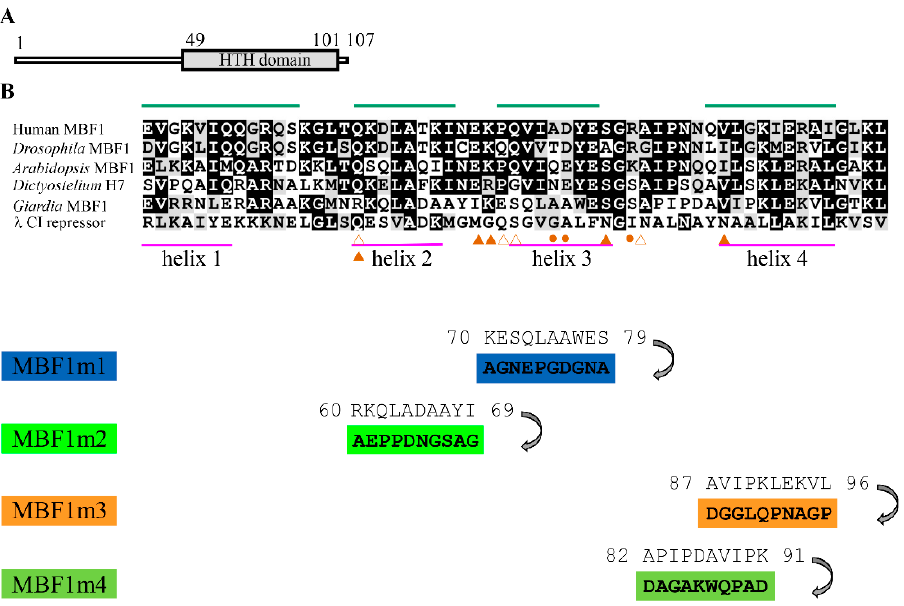
Figure 1. Domain architecture of multiprotein bridging factor 1 (MBF1) protein and alignment of the HTH domains. ( A ) Schematic representation of the Giardia MBF1 protein. The gray box indicates the helix-turn-helix (HTH) domain, as predicted by pfam. ( B ) Alignment of various HTH domains and sequence of Giardia MBF1 mutants. The MBF1 proteins from different organisms, including human, Drosophila , Arabidopsis , Dictyostelium and Giardia , are analyzed by ClustalW 1.83 with all default settings. GenBank accession numbers for human MBF1, Drosophila MBF1, Arabidopsis MBF1, Dictyostelium H7, Giardia MBF1, and λ CI repressor are NP_003783.1, NP_524110.1, NP_565981.1, CAA33444.1, XP_001704109.1, and AAK07889.1, respectively. Black and gray boxes indicate identical and conserved amino acids in the respective proteins, respectively. The predicted 4 α helixes of HTH domain of Giardia MBF1 and λ CI repressor are indicated by green and purple lines, respectively. The helix 2 and helix 3 are the core structure of λ CI repressor and the latter is the recognition helix. Amino acids of λ CI repressor that contact DNA major groove and DNA phosphates are indicated by filled and open triangles, respectively. The hydrophobic amino acids of λ CI repressor that increase DNA binding specificity are indicated by filled circles. MBF1m1 contains mutation of residues 70–79 corresponding to helix 3. MBF1m2 contains mutation of residues 60–69 corresponding to helix 2. MBF1m3 contains mutation of residues 87–96 corresponding to helix 4. MBF1m4 contains mutation of residues 82–91 corresponding to the turn between helix 3 and helix 4 and part of helix 4.